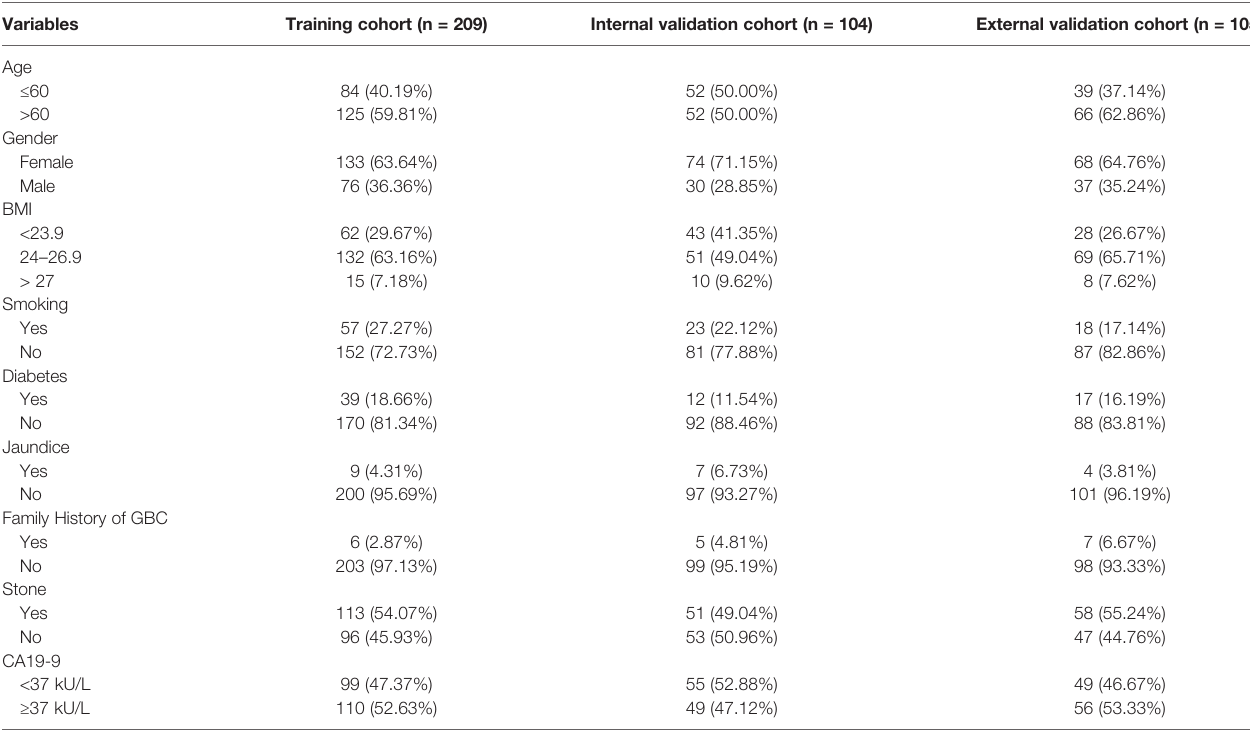
TABLE 1 | Clinical and pathologic characteristics of GBC